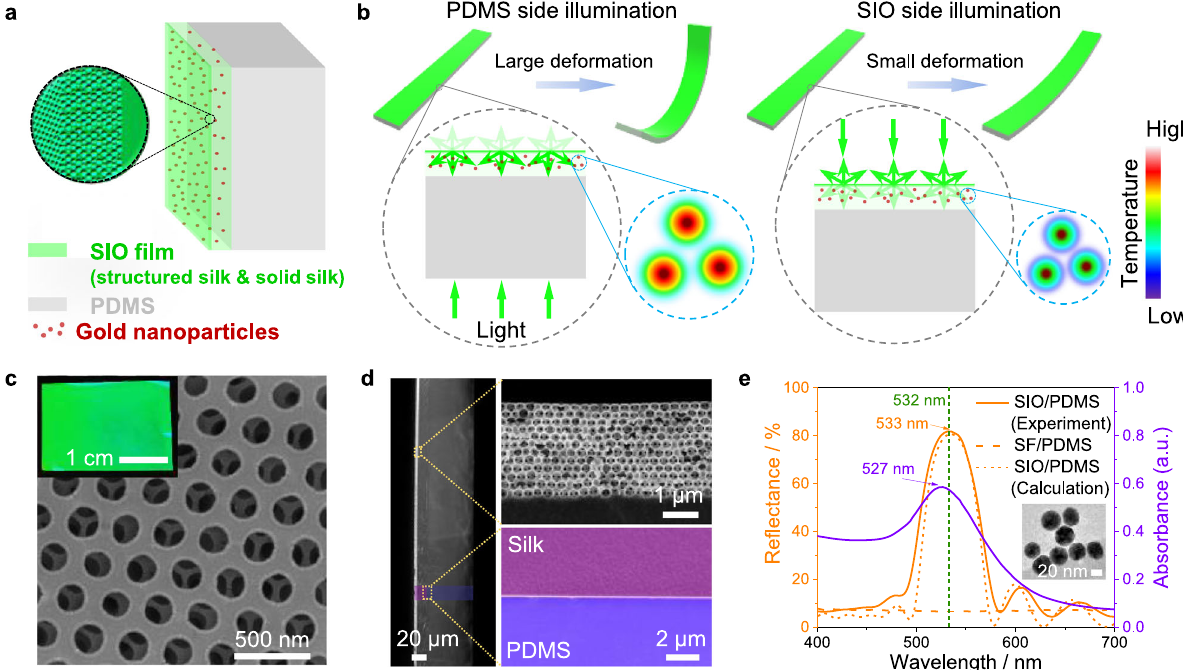
Fig. 1 Structure, mechanism, and optical properties of photonic optomechanical actuator. a Schematic illustration of the structure of photo-deformable photonic bilayer fi lm. The enlarged image shows the nanostructure of the inverse opal. b Schematics showing the mechanism of photonic-structure- controlled actuation. The photonic structure enhances (PDMS side illumination) or weakens (SIO side illumination) the gold-nanoparticles-driven photothermal conversion by controlling light propagation within the system. c Surface SEM image of SIO obtained from the colloidal crystals composed of polystyrene spheres with a diameter of 300 nm. The inset is a photograph of the as-prepared photonic bilayer fi lm, showing bright green iridescence. The image was collected in the direction perpendicular to the SIO fi lm. d Cross-sectional SEM images of the photonic bilayer fi lm. The enlarged images clearly show the photonic crystal structure displayed by ordered, hollow silk fi broin structure with air holes on the wall (top) and the compactly contacted interface between silk and PDMS (bottom). e Measured and simulated re fl ectance spectra of the photonic bilayer fi lm and absorbance spectrum of gold nanoparticles. The experimental curve is in agreement with the theoretical calculation. Inset shows a transmission electron microscopy image of the gold nanoparticles. Data for an unstructured SF/PDMS bilayer fi lm is also shown for